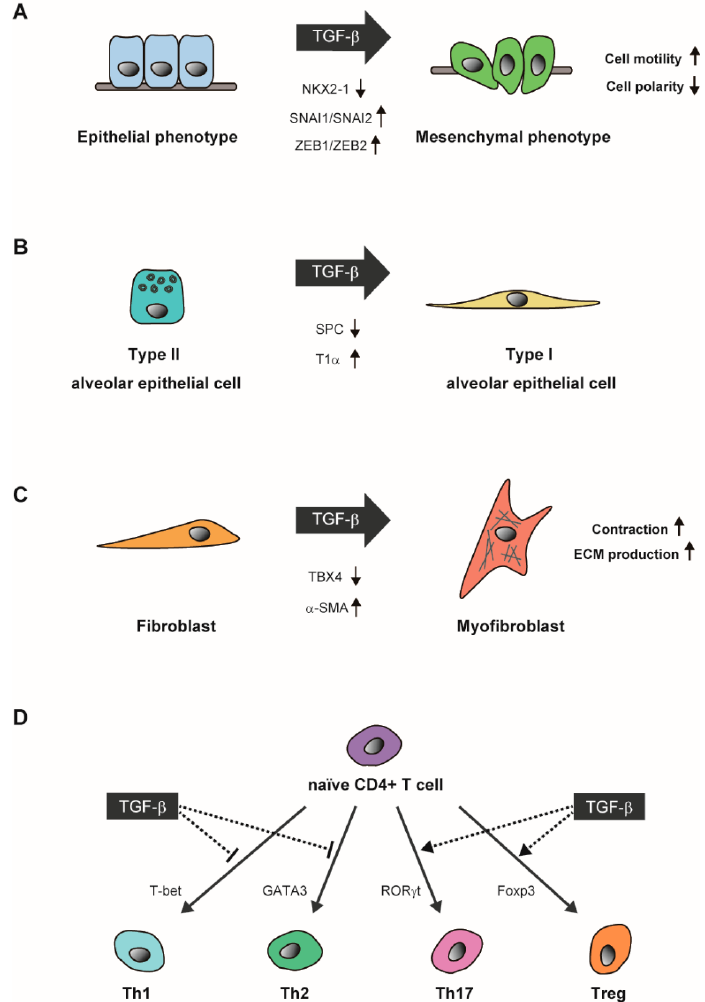
Figure 2. Context-dependent action of TGF- β . ( A ) TGF- β promotes epithelial-mesenchymal transition (EMT) in alveolar epithelial cells to confer a mesenchymal phenotype, or in lung cancer cells to enhance migratory and invasive capacities. TGF- β induces EMT-related transcriptional repressors (SNAI1/SNAI2 and ZEB1/ZEB2) and inhibits the action of NKX2-1, a homeodomain transcription factor important for lung epithelial cell differentiation; ( B ) TGF- β promotes transdifferentiation of surfactant protein C (SPC)-positive type II alveolar epithelial cells to type I alveolar epithelial cells that express podoplanin (T1 α ); ( C ) TGF- β promotes transdifferentiation of lung fibroblasts to myofibroblasts positive for α -smooth muscle actin ( α -SMA), and downregulates TBX4, a T-box family transcription factor unique to lung fibroblasts; ( D ) TGF- β suppresses induction of T helper type 1 (Th1) and type 2 (Th2) cells while positively regulating cell lineage specification from naïve CD 4+ T cells to Th17 and regulatory T (Treg) cells. T-bet, GATA3, ROR γ t, and Foxp3 are master transcription factors for Th1, Th2, Th17, and Treg cells, respectively.